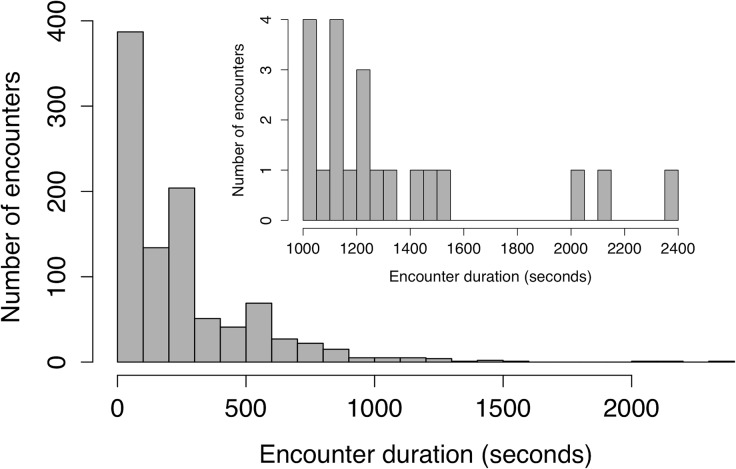
Frequencies of tag-tag durations.Inset shows the interactions >1000 s. n = 975 logs, n = 17 tagged barn swallows, and 15 hours of logging over three days.